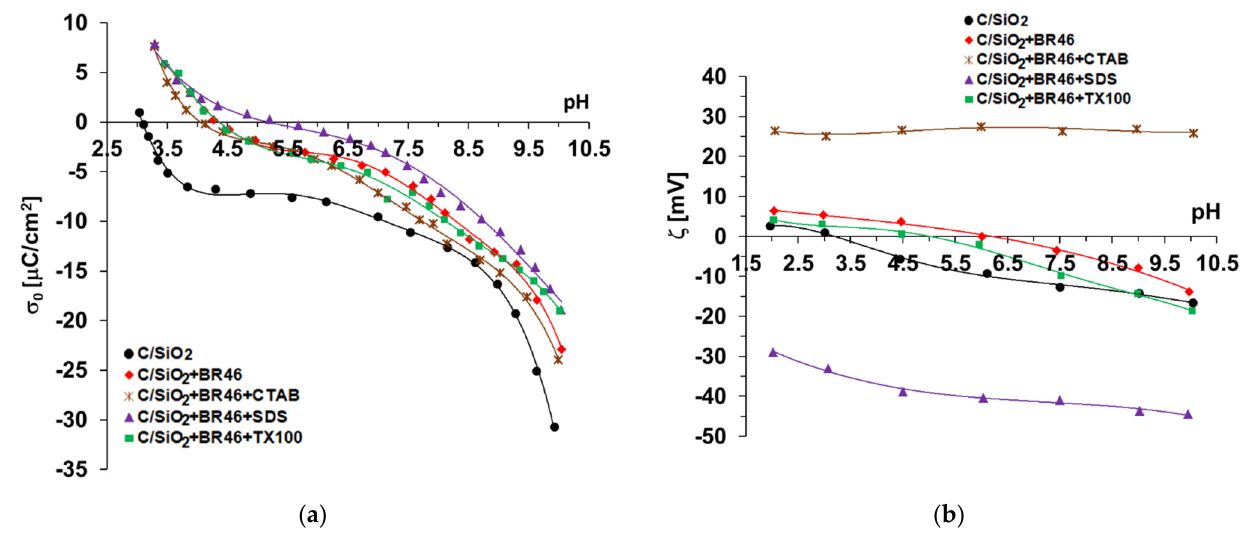
Figure 6. ( a ) Surface charge density versus solution pH and ( b ) zeta potential versus solution pH in the 100 mg/L BR46 + C/SiO 2 –surfactants (0.25 g/L) systems. the 100 mg/L BR46 + C/SiO 2 —surfactants (0.25 g/L)